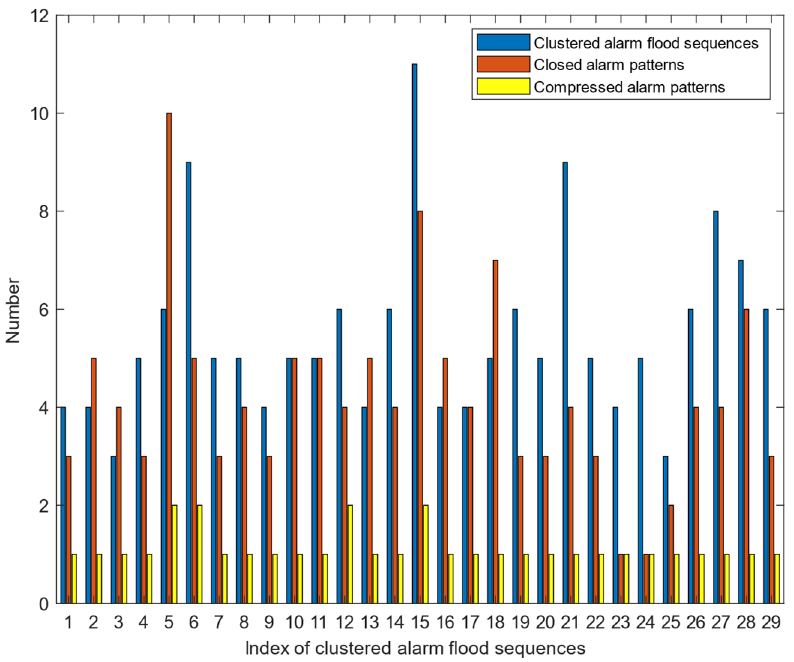
Figure 3. Numbers of clustered alarm fl ood sequences, closed alarm pa tt erns, and compressed alarm pa tt erns from 29 alarm fl ood groups. patterns from 29 alarm flood groups.